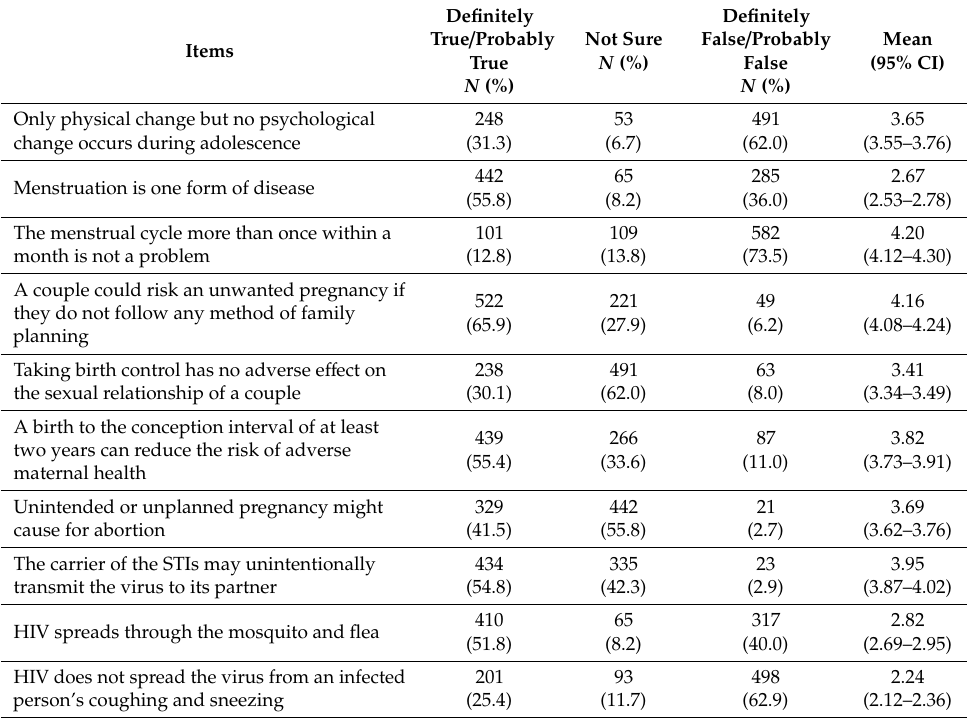
Table 2. SRH knowledge-related items of older adolescent